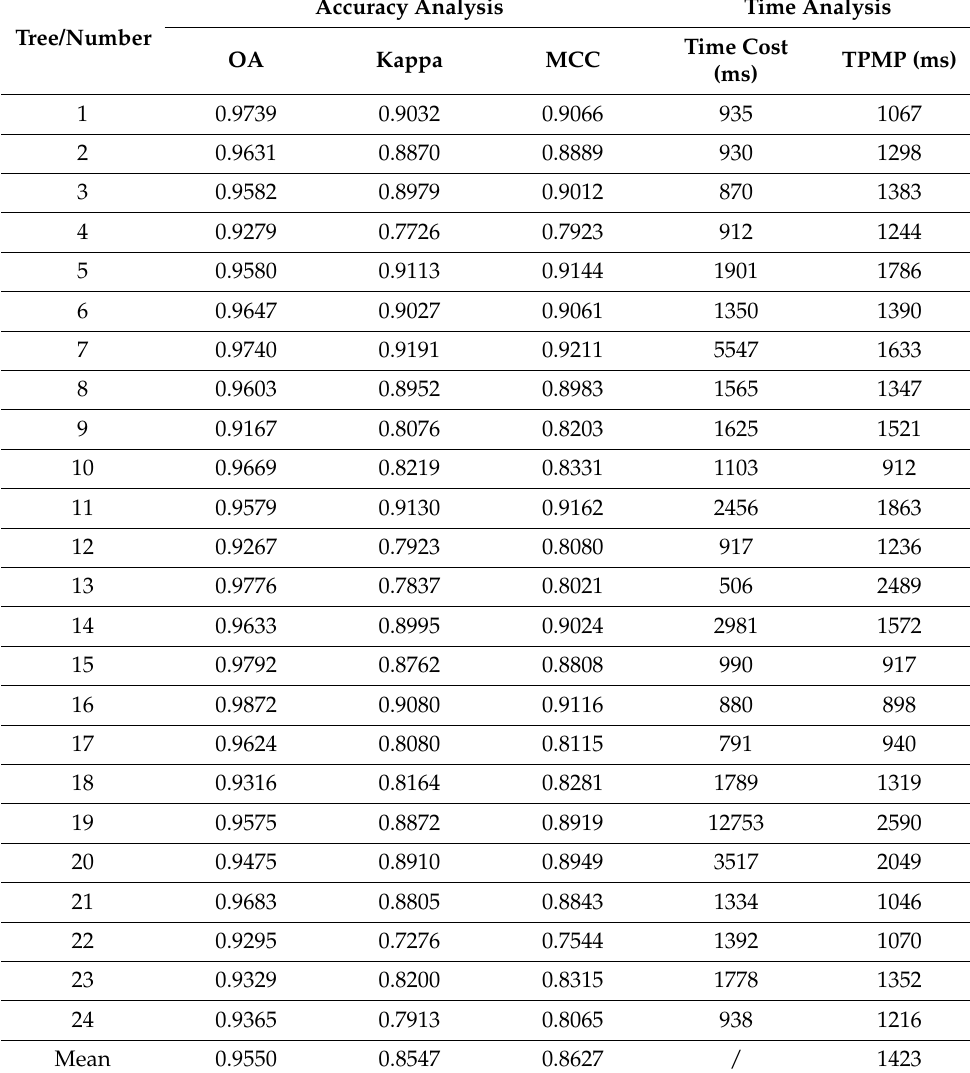
Table 5. The accuracy and efficiency analysis of 24 trees classification